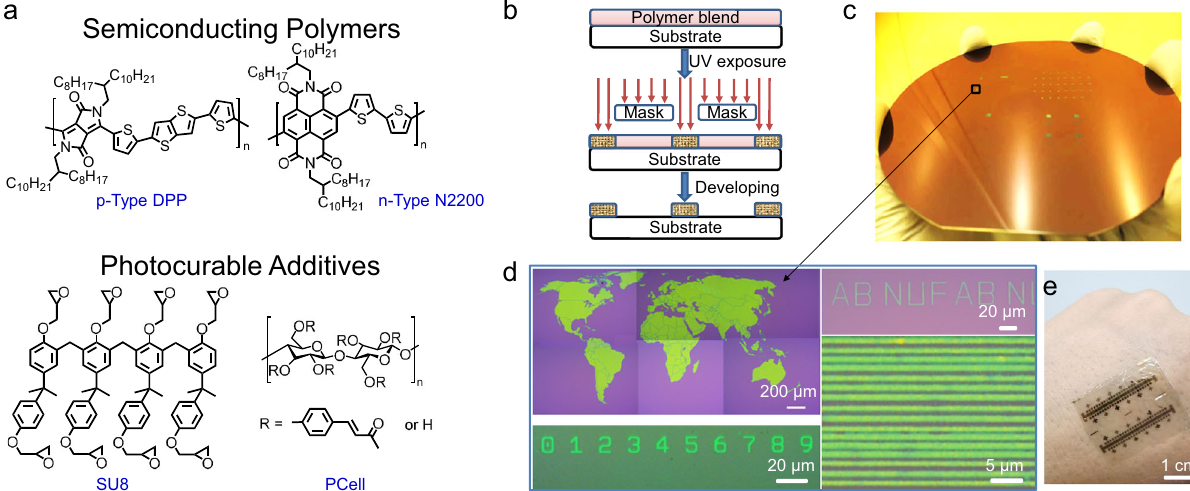
Fig. 1 Materials and methodology used to produce high-resolution patterned ultra fl exible soft matter electronic circuitry. a Chemical structures of the semiconductors and photocurable additives used in this study. b Schematic of the photolithographic process. c Photograph of a patterned 50% DPP/SU8 (DPP:SU8 = 1:1 w/w) fi lm on a 4-inch SiO 2 /Si wafer. d Optical images of 50% DPP/SU8 fi lms with various patterned topologies. e Photographic image of ultra fl exible 50% DPP/SU8-based organic TFTs (OTFTs) on a human